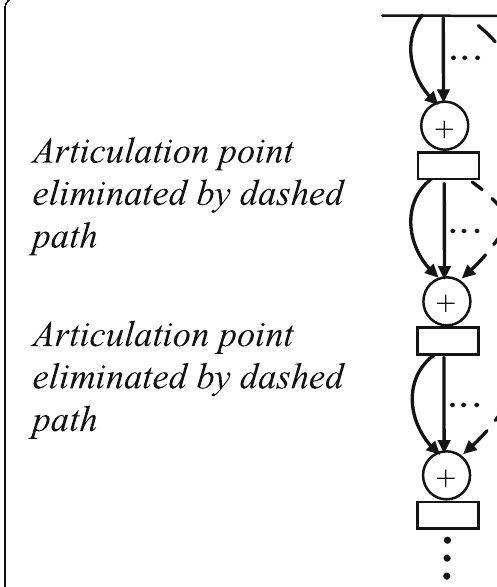
Fig. 8 Non-multiplicative graph with p = 3 depth levels and p − 1 extra R -operations in the form of pure